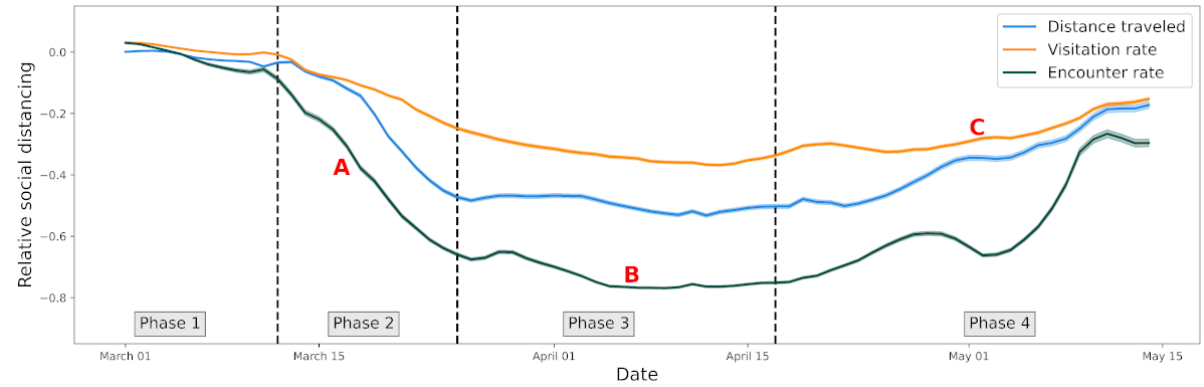
Figure 1. Time series of three mobility measures aggregated at the country level. We show a 7-day rolling mean of distance traveled (blue), visitation rate (orange), and encounters rate (green), with the solid line representing the mean and the shaded area two standard errors of the mean. The 4 phases in the mobility time series are delimited by dashed vertical lines in the figure and were generated from the model fit in each county independently. These phases allow us to calculate three summary measures for each time series: the slope of decline in phase 2 (A), the mean level of mobility during social distancing (B), and the slope of increase in mobility during exit from social distancing